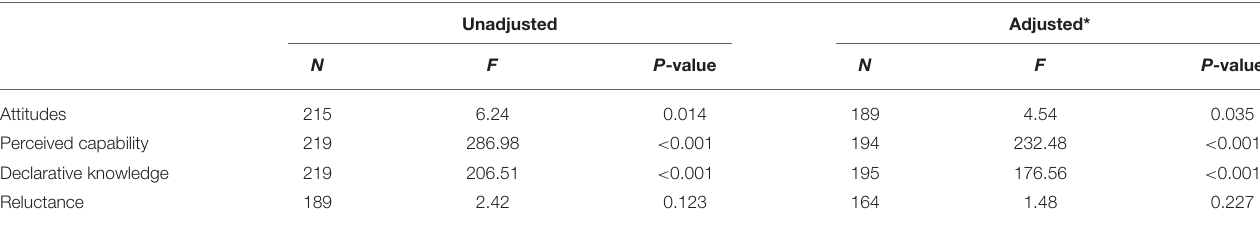
TABLE 5 | Fixed effect estimates of time (change pre to post) predicting main outcome measures in unadjusted and adjusted linear mixed-effects